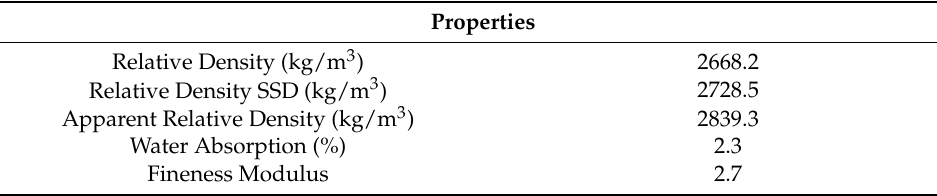
Table 3. Sand characterization.